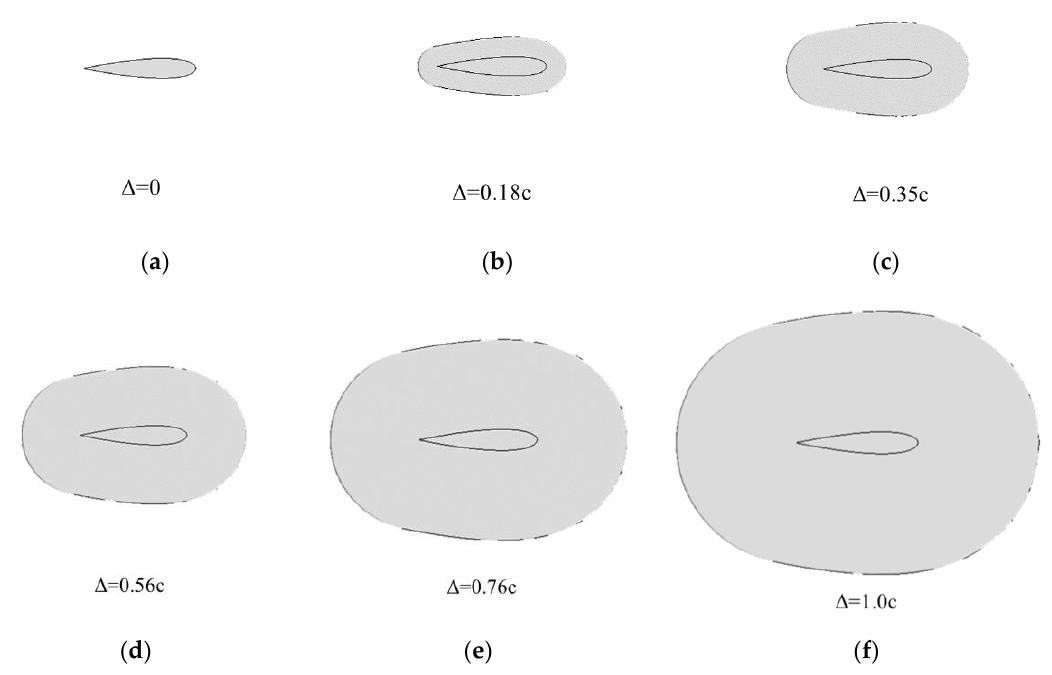
Figure 17. Perspective view of six bulkhead sizes: ( a ) ∆ = 0; ( b ) ∆ = 0.18c; ( c ) ∆ = 0.35c; ( d ) ∆ = 0.56c; ( e ) ∆ = 0.76c; ( f ) ∆ = 1.0c.